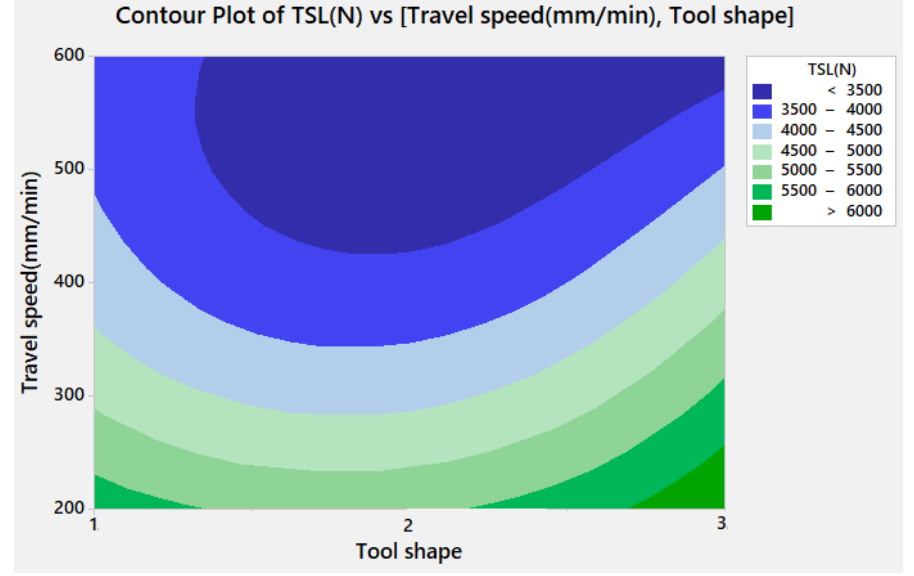
Figure 10. Contour plot for TSL versus travel speed and tool shape.